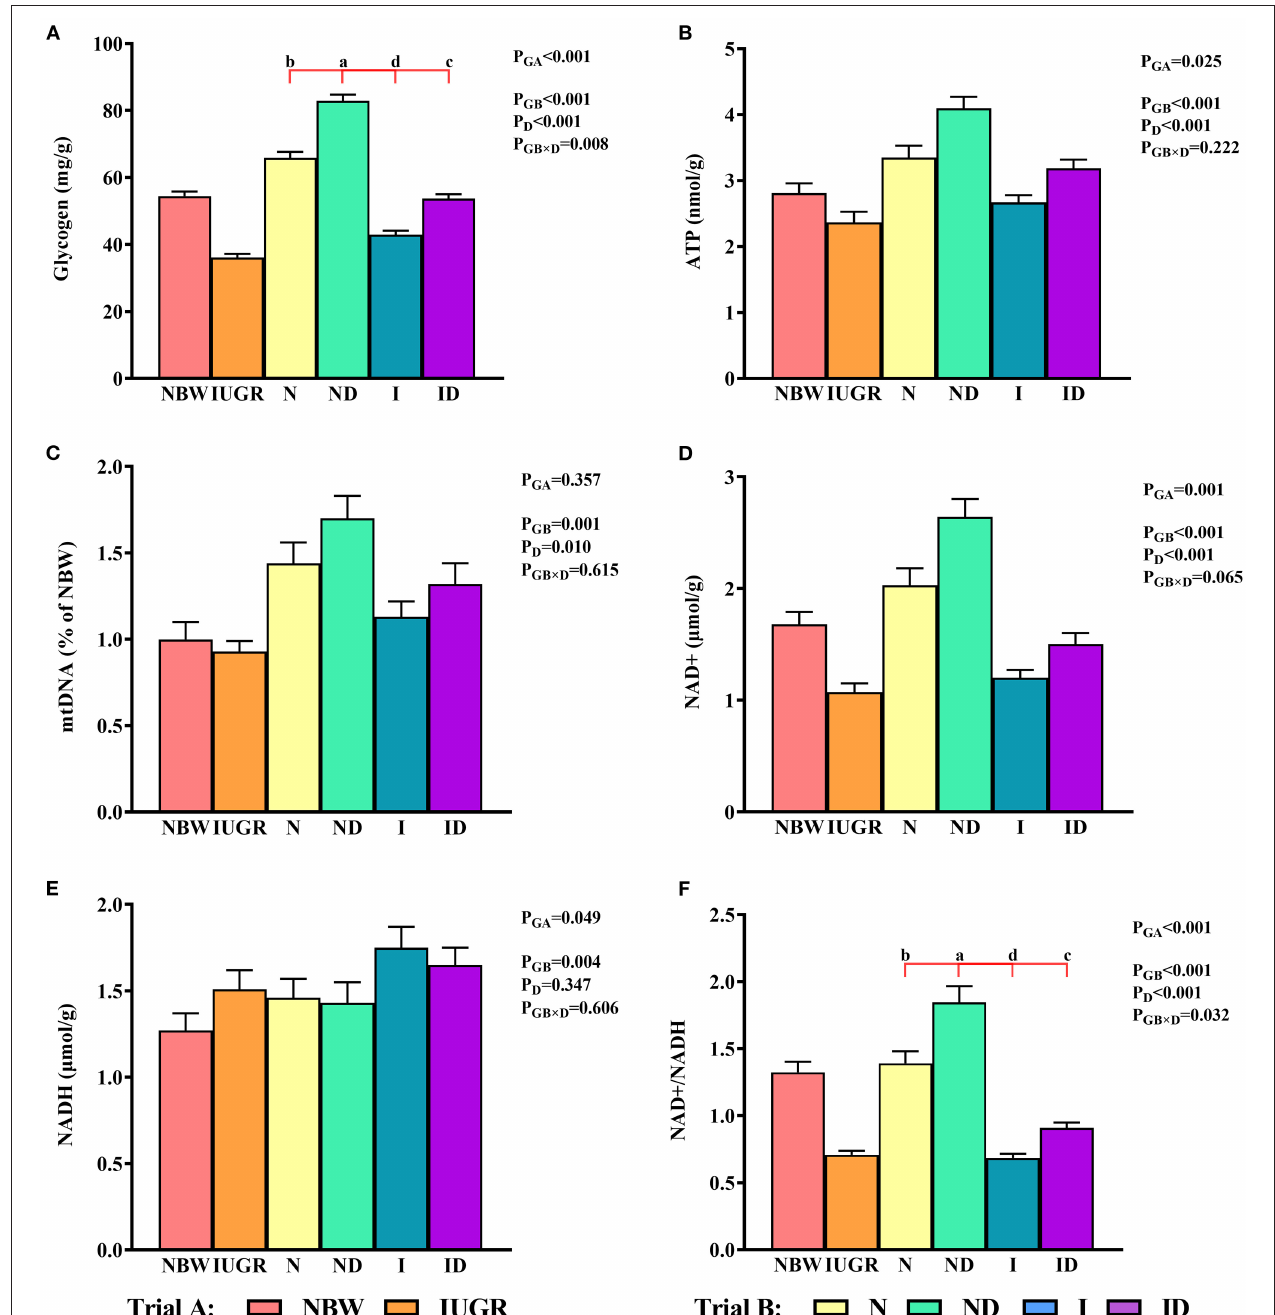
FIGURE 7 | (A–F) Supplementation with DMG-Na improved the hepatic energy metabolism in IUGR suckling piglets. Data are expressed as the mean ± SD; n = 10 suckling piglets per group. The P -value (Trial A: NBW, IUGR group in black color) and a, b, c, d (Trial B: N, ND, I, ID group in red color) represent significant differences ( P < 0.05). NBW, normal birth weight newborns; IUGR, intrauterine growth restriction newborns; N, NBW newborns fed a basic milk diet; ND, NBW newborns fed a basic milk diet plus 0.1% DMG-Na; I, IUGR newborns fed a basic milk diet; ID, IUGR newborns fed a basic milk diet plus 0.1% DMG-Na; ATP, adenosine triphosphate; NAD + , nicotinamide adenine dinucleotide; NADH, nicotinamide-adenine dinucleotide.